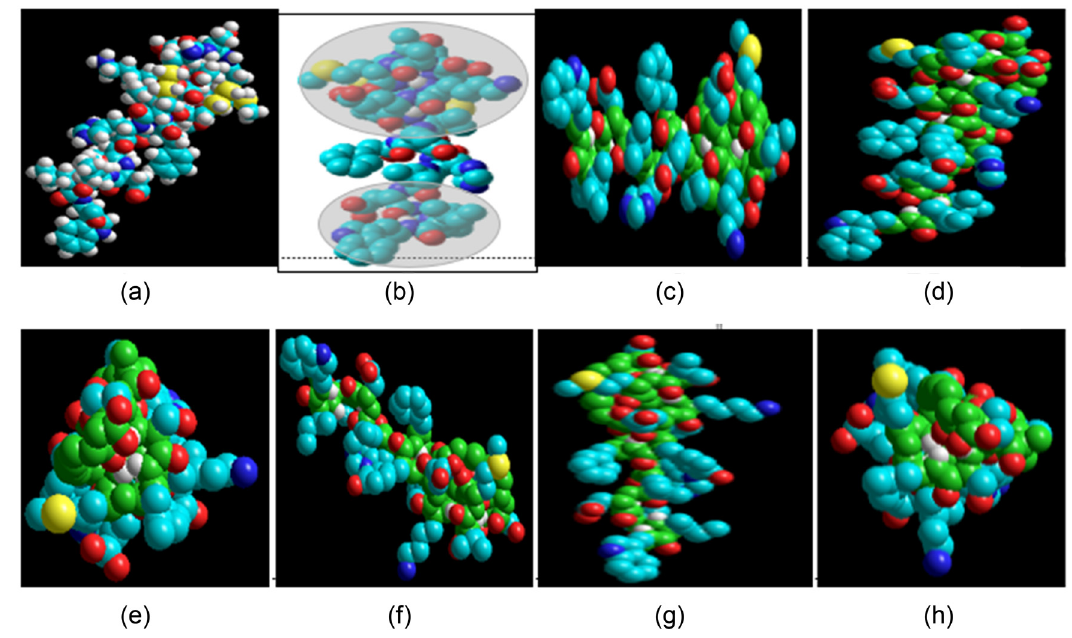
Figure 2: Peptide folds, ET - I based with compartmentalization, and the sequence ’ s geometries: Emerging structural orientations with resultant geometry and axial alignments of the molecule providing di ff erent views of the geometry, with all the back - bone atoms in the models appearing as green atoms; ( a ) molecule leading to compartmentalization, shown with the explicit hydrogen atoms; ( b ) nearly three distinct major regions are appearing; ( c ) primary X - axis alignment; ( d ) Y - axis alignment; ( e ) primary Z - axis alignment, probably for passage through channels; ( f ) secondary Y - axis alignment; ( g ) secondary Z axis; ( h ) tertiary X ( as major axis ) , primary Y axis orientation. Structures are shown without explicit hydrogens, the space - fi lling models ’ explicit hydrogens are white, the carbon atom is magenta colored, oxygen is red, nitrogen blue, and sulfur is yellow colored, the color scheme follows the current and all the subsequent models, unless otherwise